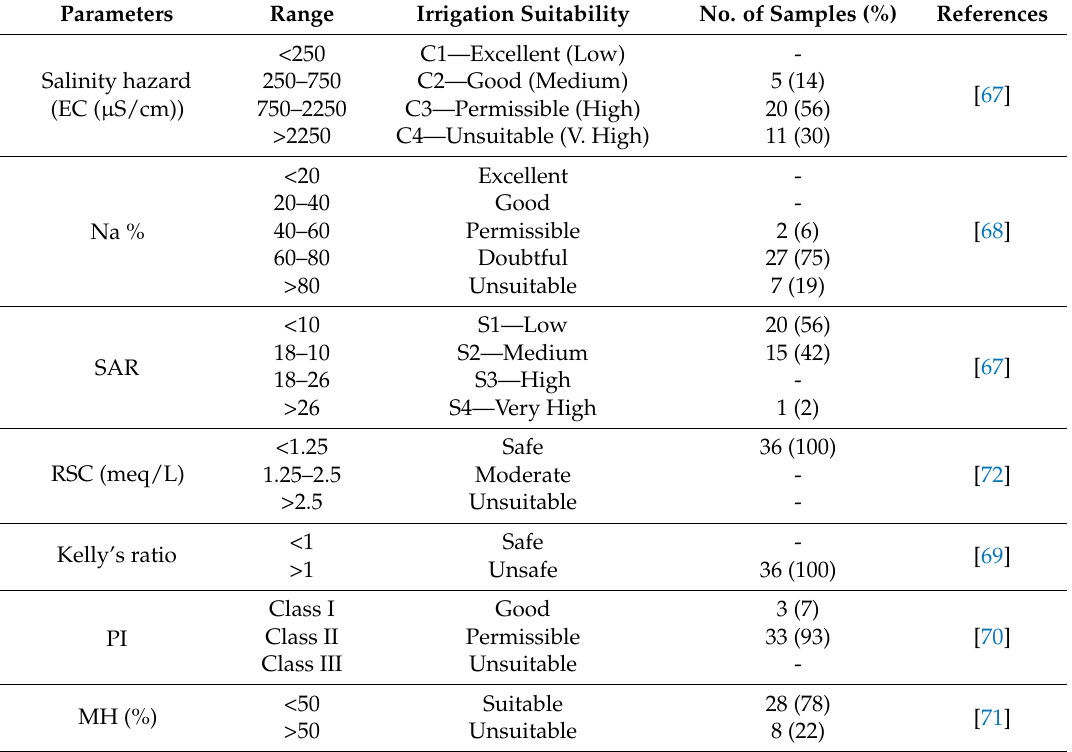
Table 8. Classification of groundwater samples for